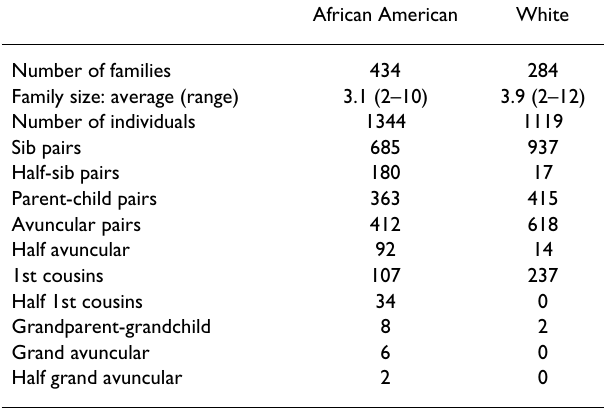
Table 2: Distribution of Family Structures African American